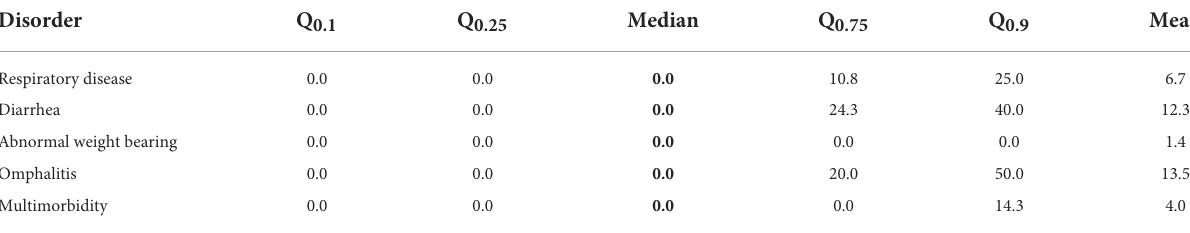
TABLE 8A Herd prevalence of disorders in preweaned dairy calves on 130 farms with 1 to 40 dairy cows * .